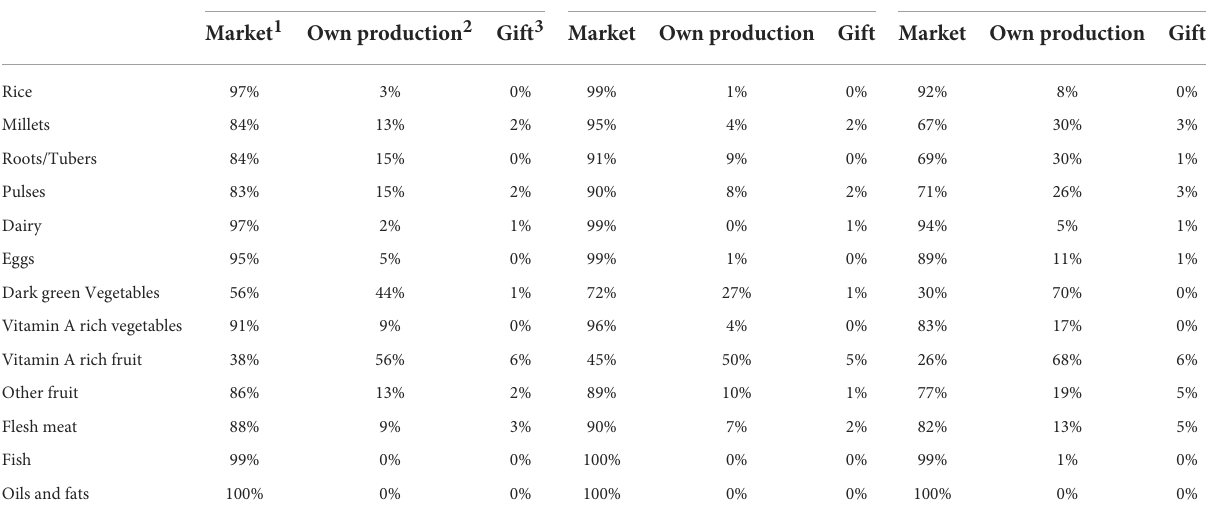
TABLE 6 Main food sourcing patterns by